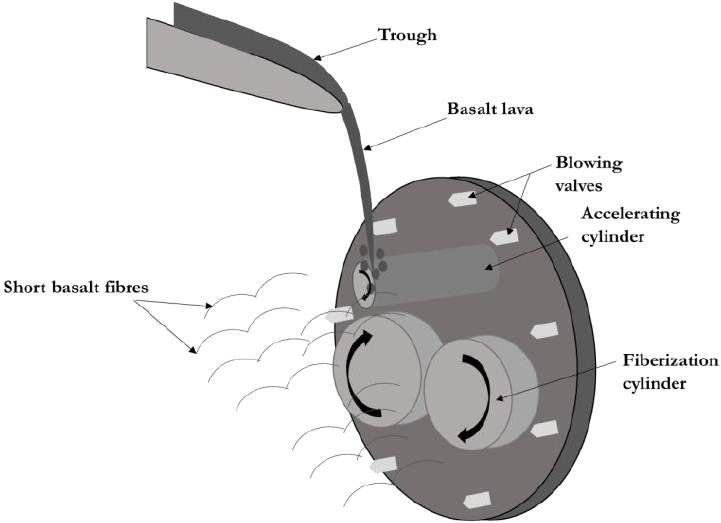
Figure 2. Schematic of Junkers technology (redrawn from [30,31]).